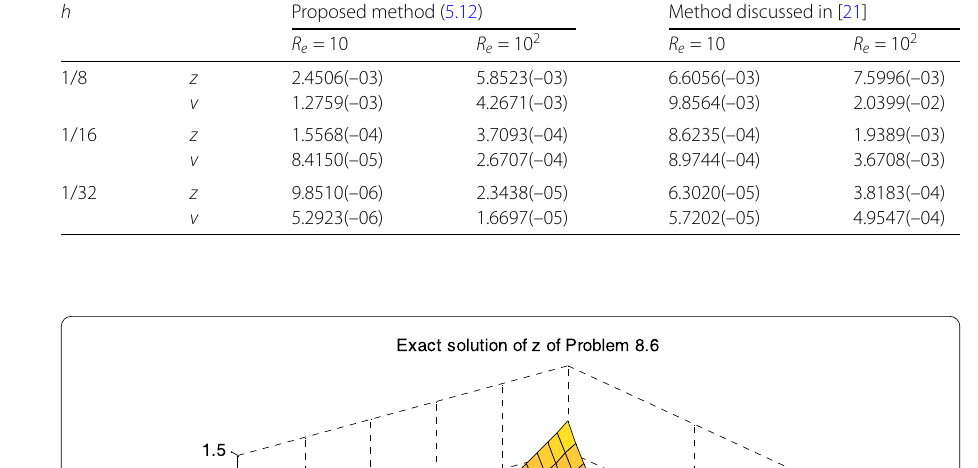
Table 6 Problem 8.6: The maximum absolute errors h Proposed method (5.12)